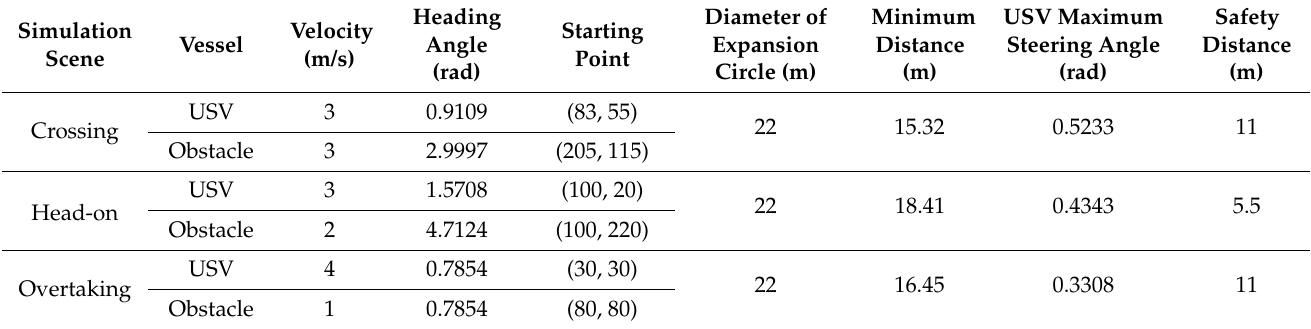
Table 2. Simulation data of traditional VO for a single Table 3. Simulation data of improved VO for a single ship.